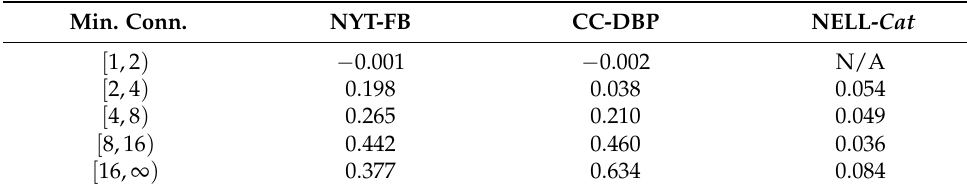
Table 6. KBP’s increased AUC by minimum connectivity group. Min.